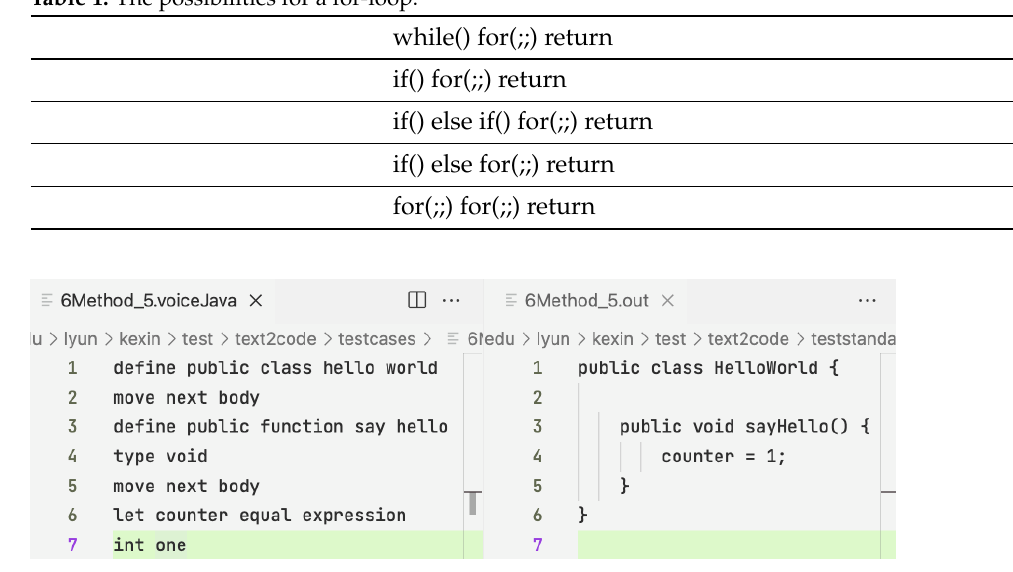
Figure 6. An example of .voiceJava and .out files.